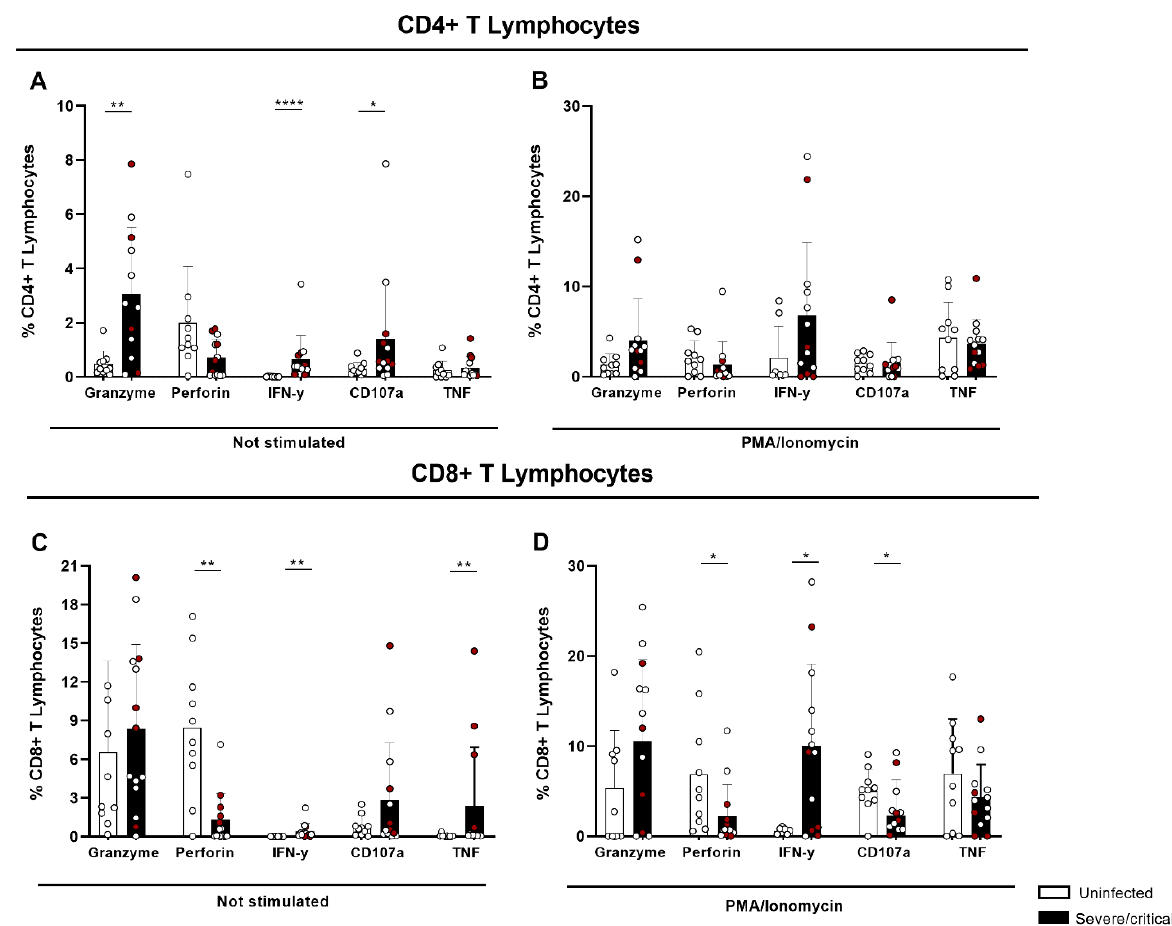
Figure 4. Cytotoxic profile of CD4+ and CD8+ T lymphocytes in SARS-CoV-2 infection. The graphs represent the cytotoxic profile (granzyme A, perforin, CD107a, IFN- γ , and TNF) of CD4+ and CD8+ T lymphocytes from PBMCs from uninfected controls and from patients with severe/critical COVID-19: basal levels of the cytotoxic profile of ( A ) CD4+ T lymphocytes and ( D ) CD8+ T lymphocytes, and upon stimulation with PMA and Ionomycin of ( B ) CD4+ T lymphocytes and ( C ) CD8+ lymphocytes. The red dots represent patients with critical infections. The bars represent the median and interquartile range. * p < 0.05, ** p < 0.01 and **** p < 0.0001.